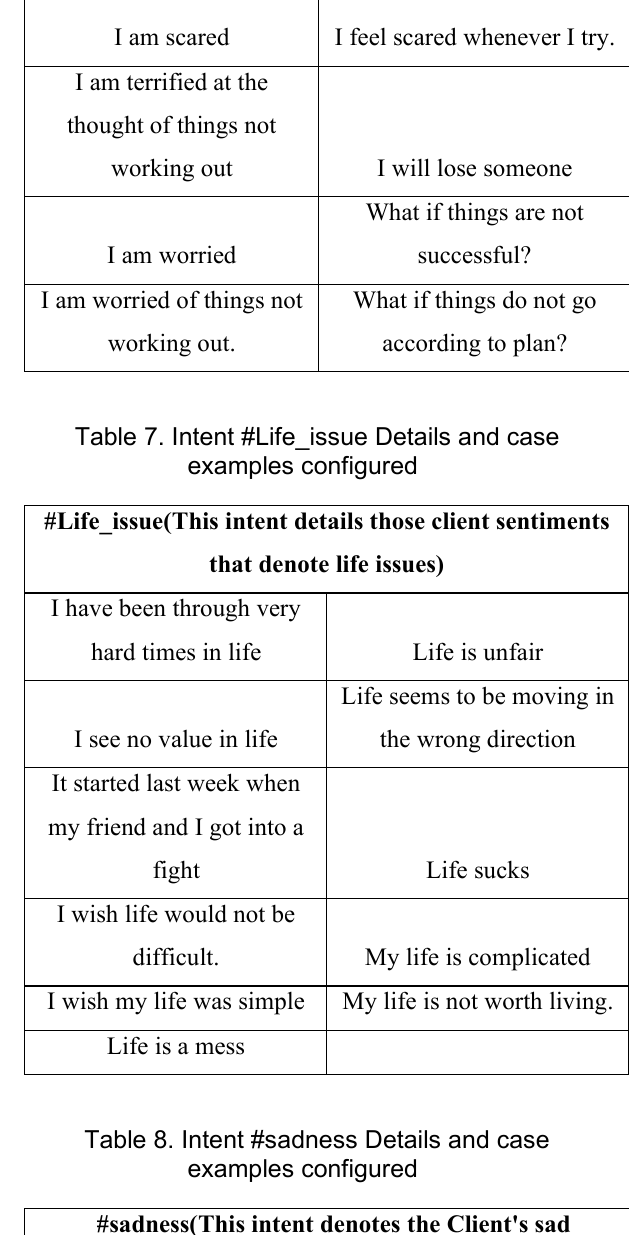
Table 8. Intent #sadness Details and case examples